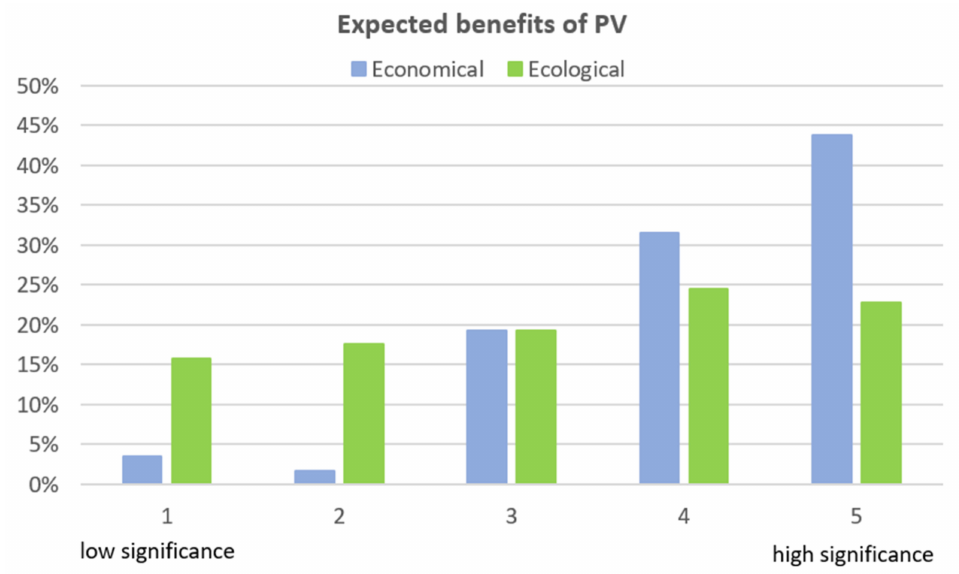
Figure 1. Expected benefits of a PV installation ( n = 57). Source: own study.